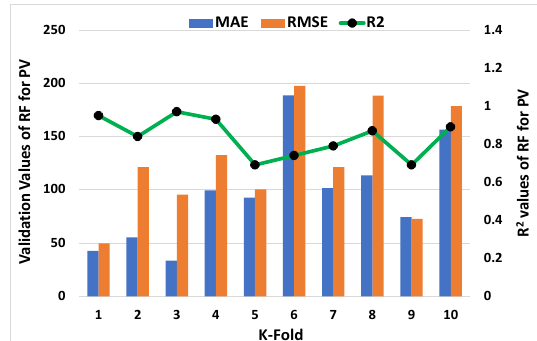
Figure 12. K-fold result of plastic viscosity from R-F model.